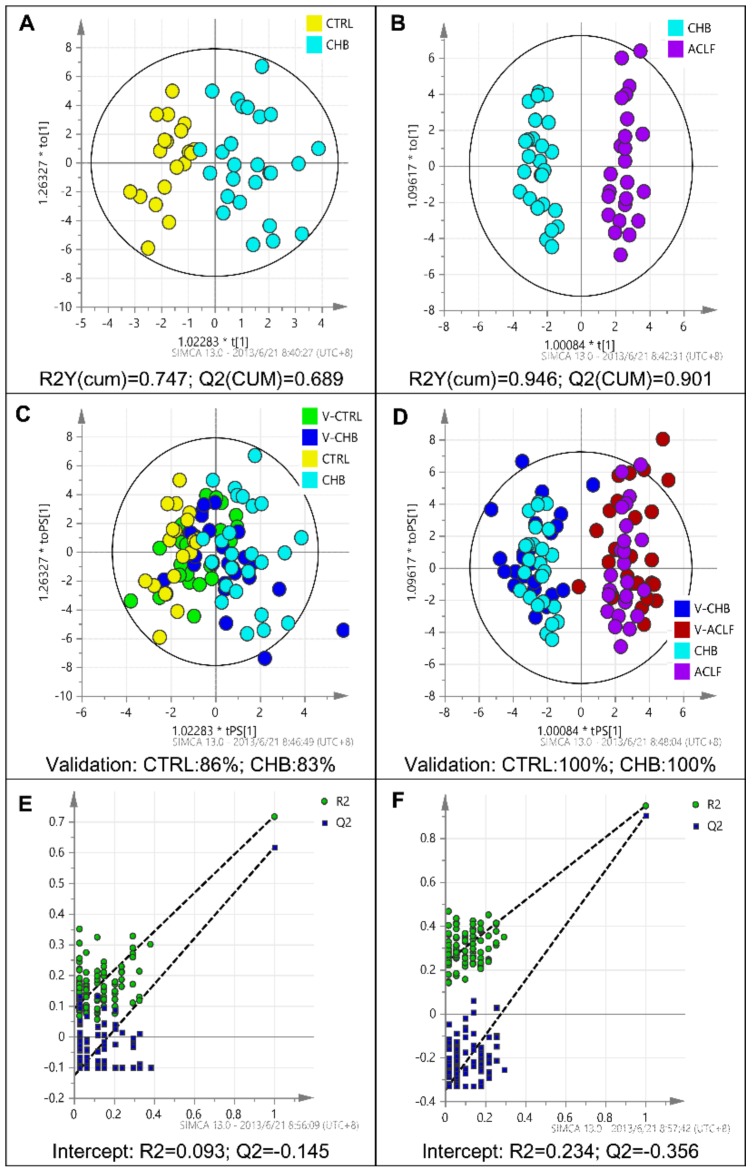
Identification of potential biomarkers through OPLS-DA.(A),(B). Score plots obtained from the training cohort by OPLS-DA. R2Y(cum) and Q2(cum) values are displayed below each panel; these values have a range of 0 to 1 and represent the stability and predictability of the model, respectively. Dots with different colors representing different groups are well separated based on their sphingolipidome data, indicating serum sphingolipidome varied among groups significantly. (C),(D). T-predicted scatter plot of the OPLS-DA model using sphingolipidome data obtained from the validation cohort. The result shows that the OPLS-DA models correctly predicted 86% of V-CTRL and 83% of V-CHB patients within the 95% CI (panel C, CTRL vs. CHB), and correctly predicted 100% of V-CHB and 100% of V-CTRL subjects within the 95% CI (panel D, CHB vs. ACLF). (E),(F). Validation plot of the PLS-DA models obtained using 100 permutation tests to reveal the risk of overfit from the model. The intercept for the blue Q2 line should be below 0.1. Note: V-: corresponding validation group in the validation cohort.